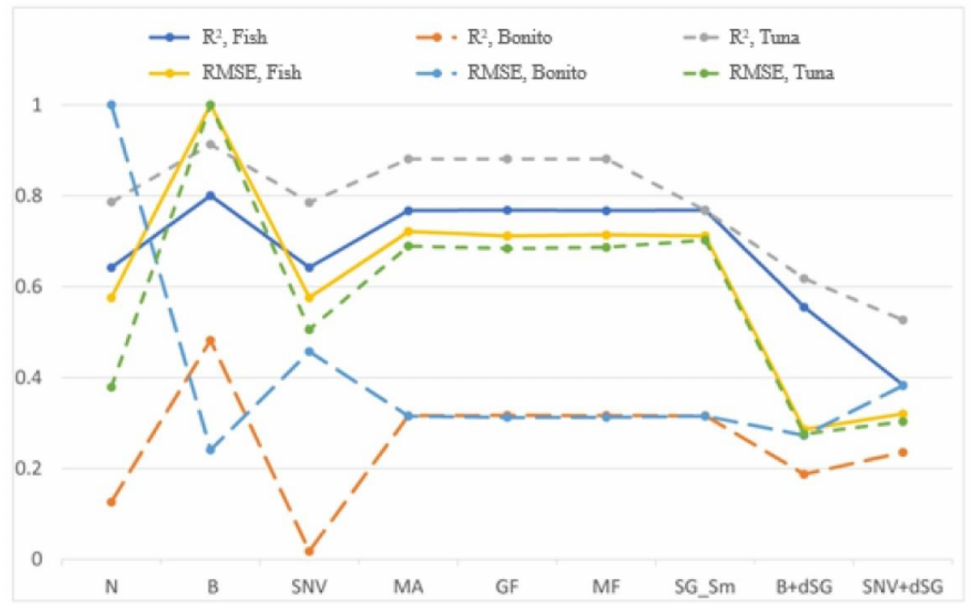
Figure 2. Validation results of PLSR equations for different input data, obtained by different prepro- cessing of SERS spectra of combined fish samples (Fish) and individual fish species (tuna, bonito) with corresponding root mean square errors